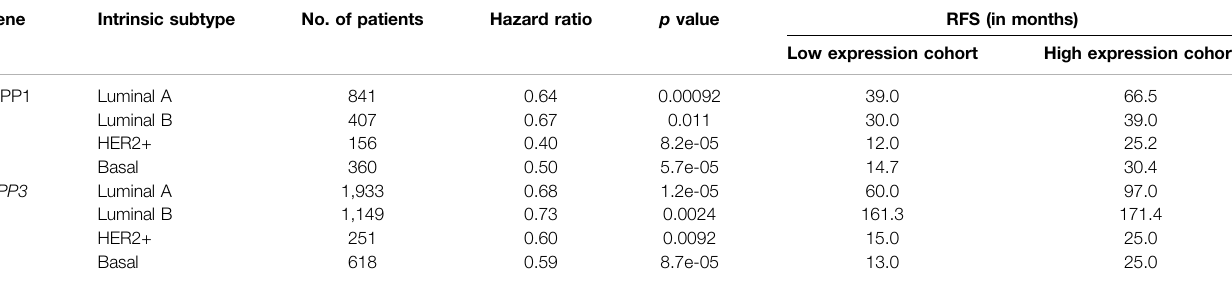
TABLE 1 | Correlation between mRNA expression of SGPP1 and PLPP3 with relapse-free survival in the different breast cancer intrinsic subtypes. Gene Intrinsic subtype No. of patients Hazard